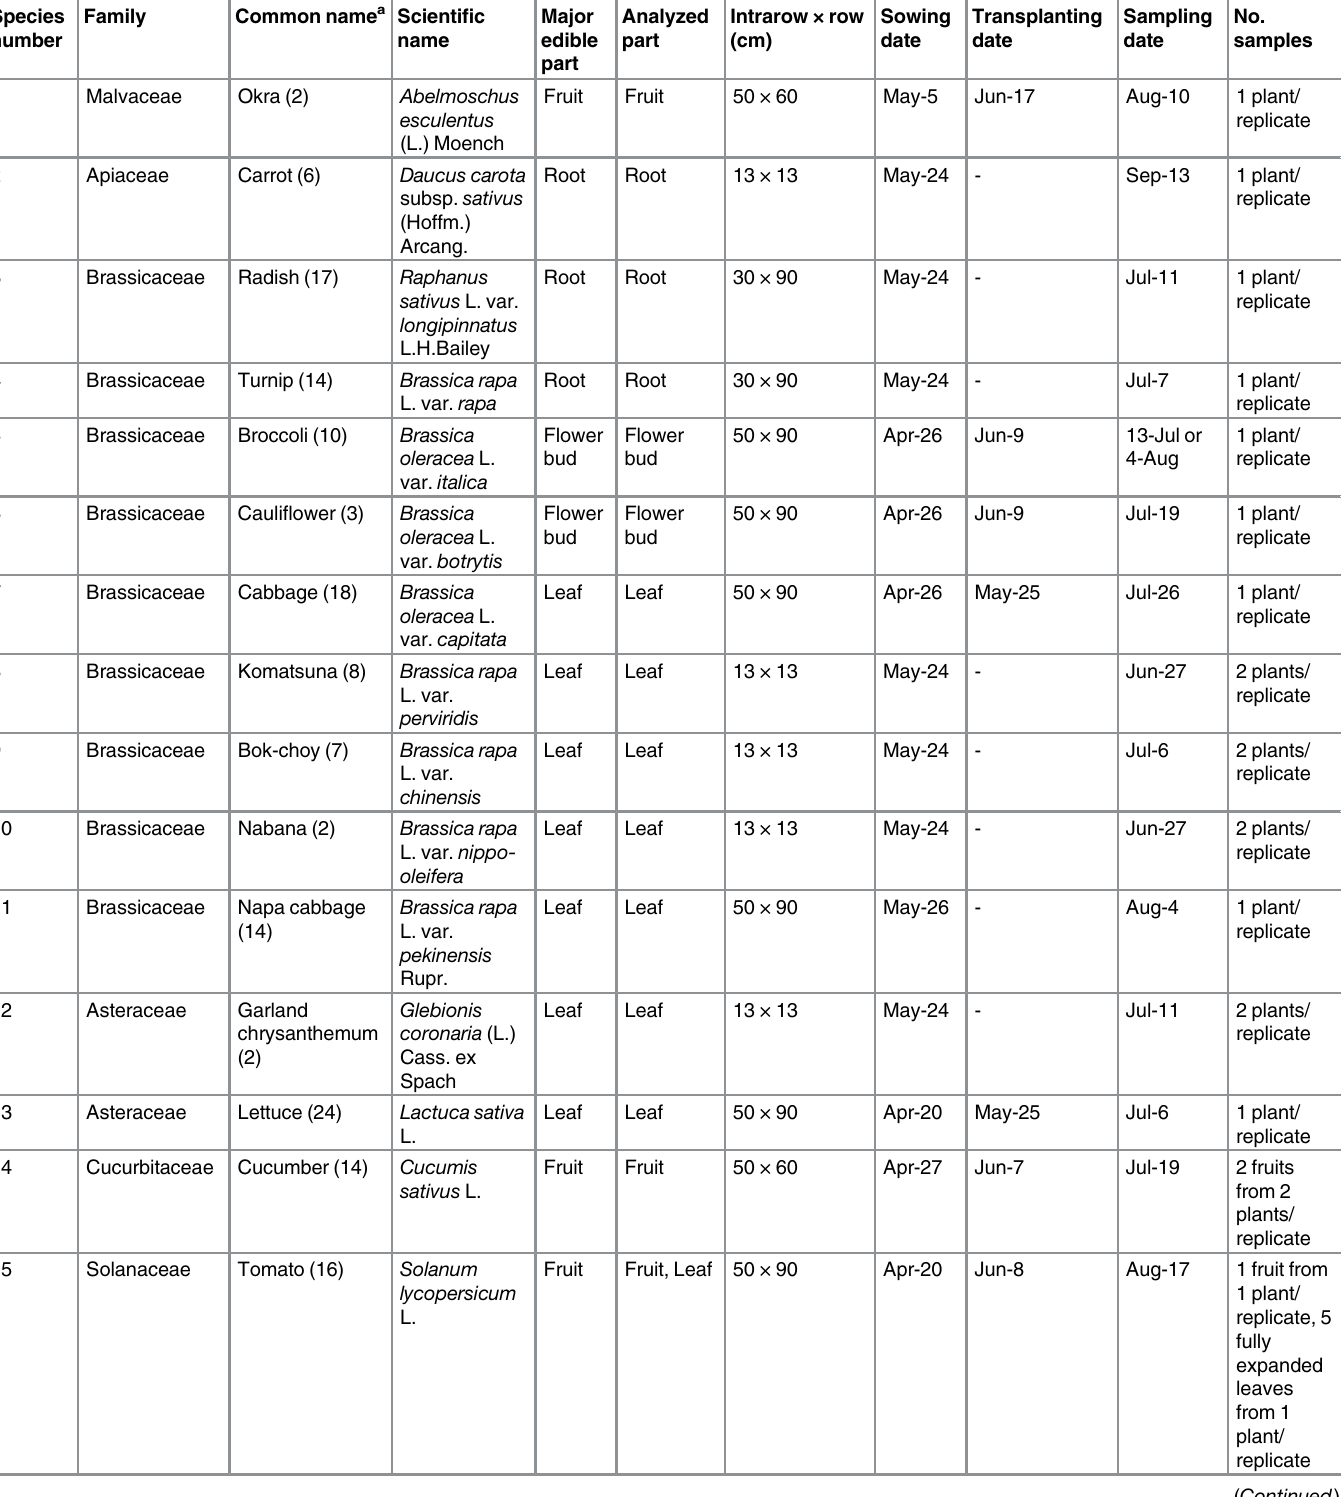
Table 1. List of the vegetable species used in this study and details about the sowing, transplanting, and sampling procedures. Species number